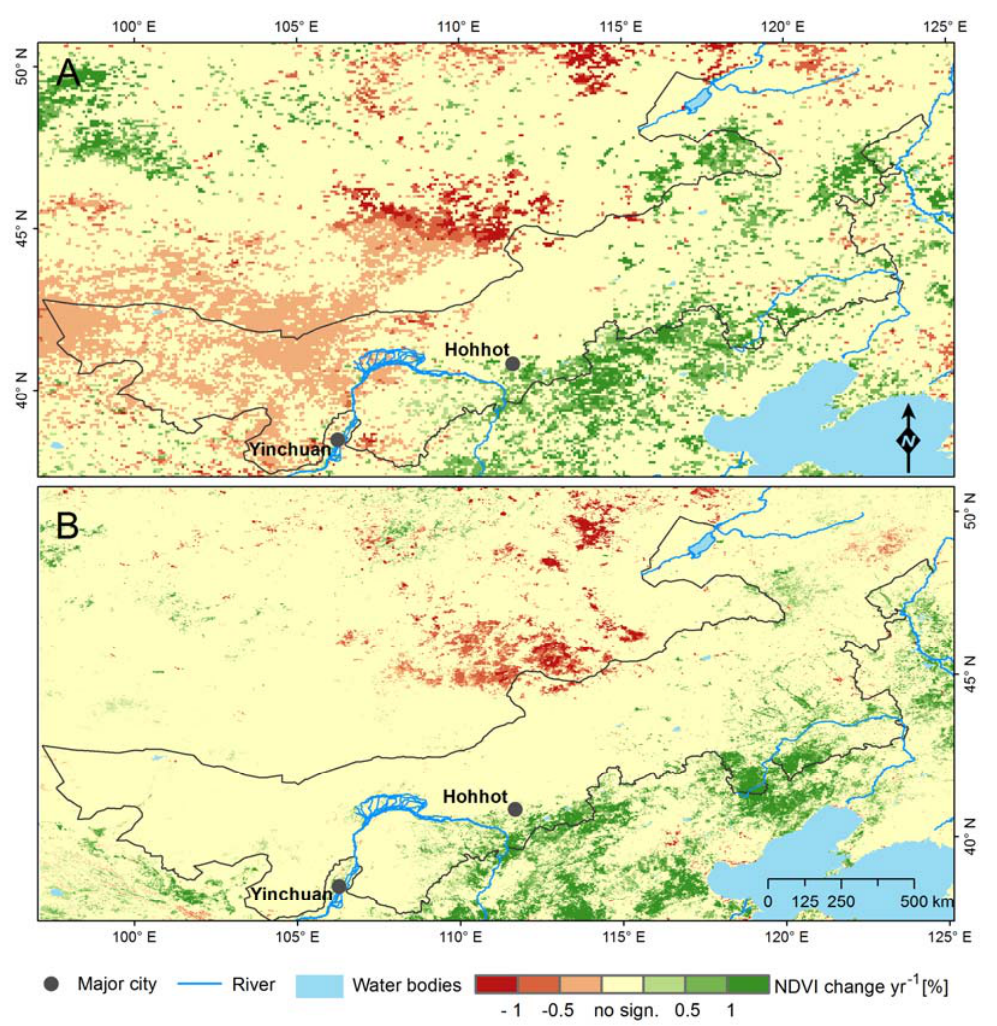
Figure 4. Maps of NDVI change between 1999 and 2006 based on statistically significant Sen’s slope of 8-km AVHRR GIMMS ( A ) and 1-km SPOT VGT ( B ) time series ( p < 0.05, MSK test). Comparison of Sen’s slope values for different phenological parameters based on 2,770 sampling plots ( C